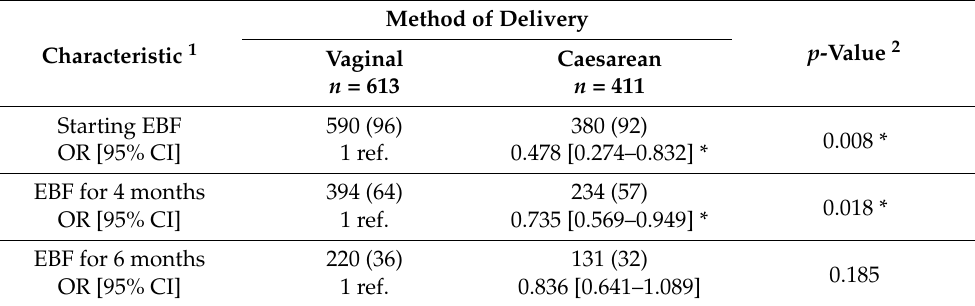
Table 2. The odds ratio (OR) for exclusive breastfeeding (EBF) practice depending on the method of delivery ( n =